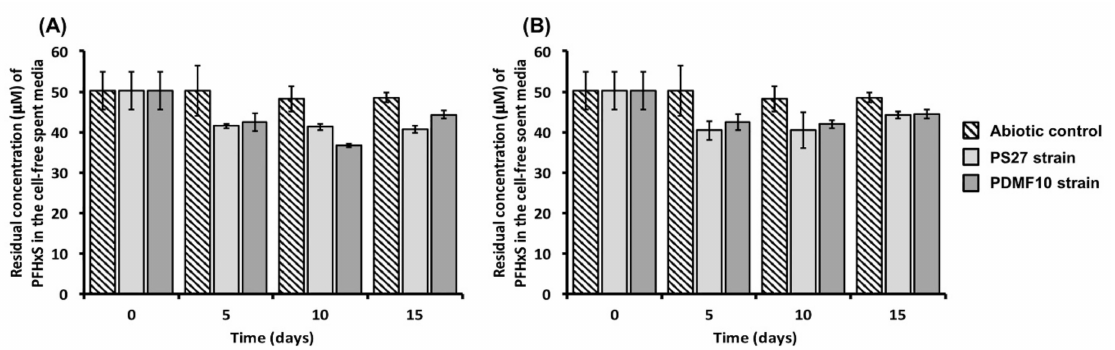
Figure 3. Removal e ffi cacy of PFHxS performed by PS27 and PDMF10 growing cells under either octane ( A ) or ethanol-octane ( B )